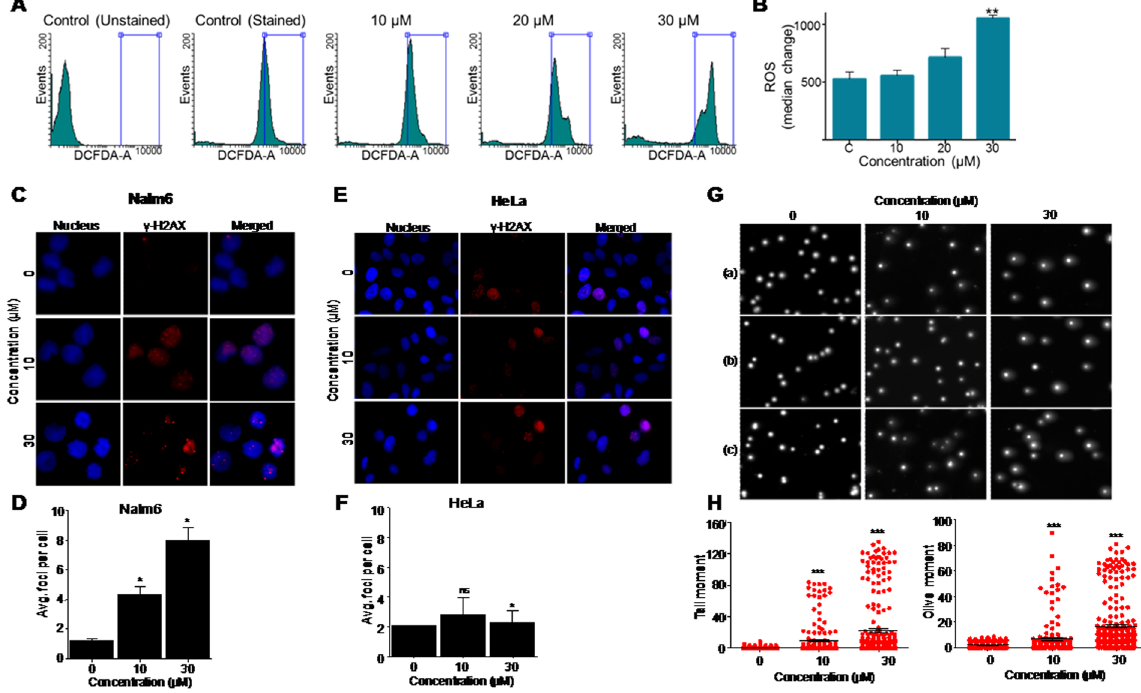
Figure 5. Evaluation of ROS generation and DNA damage within cells following 5g treatment in Nalm6 cells. ( A) Histogram showing ROS generation after treatment with different concentration of 5g in Nalm6 cells. 5g-treated (0, 10, 20 and 30 µ M; 48 h) Nalm6 cells were stained with DCFDA and subjected to FACS analysis. ( B ) Median change with respect to control was quantified and presented as bar diagram with error bars (n = 3). Statistical significance was calculated using student t-test and significance was shown if the p-value was equal to or less than 0.05 ( * 0.05, ** 0.005, *** 0.0005). ( C ) Representative microscopy images depicting immunofluorescence in Nalm6 cells to detect γ -H2AX foci formation upon treatment with 5g (0, 10, 20 and 30 µ M; 24 h). Nucleus is stained using DAPI (blue), γ -H2AX is depicted in red, and the merged image is shown on the right. ( D ) Bar graph depicting average number of foci per cell in Nalm6 cells treated with 5g. A minimum of 100 cells were screened for each sample, foci counted, and plotted as a bar graph showing mean ± SEM (p value: * 0.05, ** 0.005, *** 0.0005). ( E ) Representative images showing γ -H2AX staining (red) in HeLa cells upon 24 h of 5g treatment (0, 10, 20 and 30 µ M; 24 h). Cells have been counter stained with DAPI to depict nucleus, and merged image is presented at the right side. ( F ) Quantification showing the average number of γ -H2AX foci per cell, plotted as a bar graph depicting mean ± SEM. ( G ) Representative images depicting Nalm6 cells subjected to comet assay analysis post treatment with 5g (0, 10, 20 and 30 µ M; 48 h). Cells were stained with propidium Iodide, following neutral comet analysis. Panels a, b and c represent three independent field views from the same sample. ( H ) Scatter plots showing quantification of the extent of DNA double-strand breaks in Nalm6 cells, post 5g treatment. A minimum of 100 cells were analyzed in each case, and Tail Moment (left panel) and Olive Moment (right panel) were calculated by using CometScore software. Each dot represents an individual cell in the quantification panel. All experiments were repeated a minimum of three times, and the error bar plotted as mean ± SEM (p value: * 0.05, ** 0.005, ***